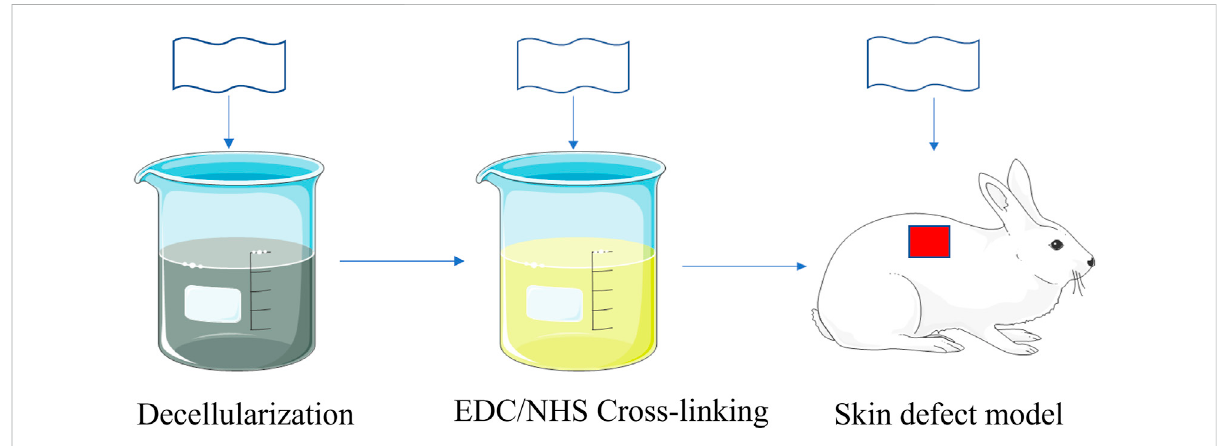
FIGURE 1 Schematic illustration of fabricating and implantation of EDC/NHS Cross-linking swimming